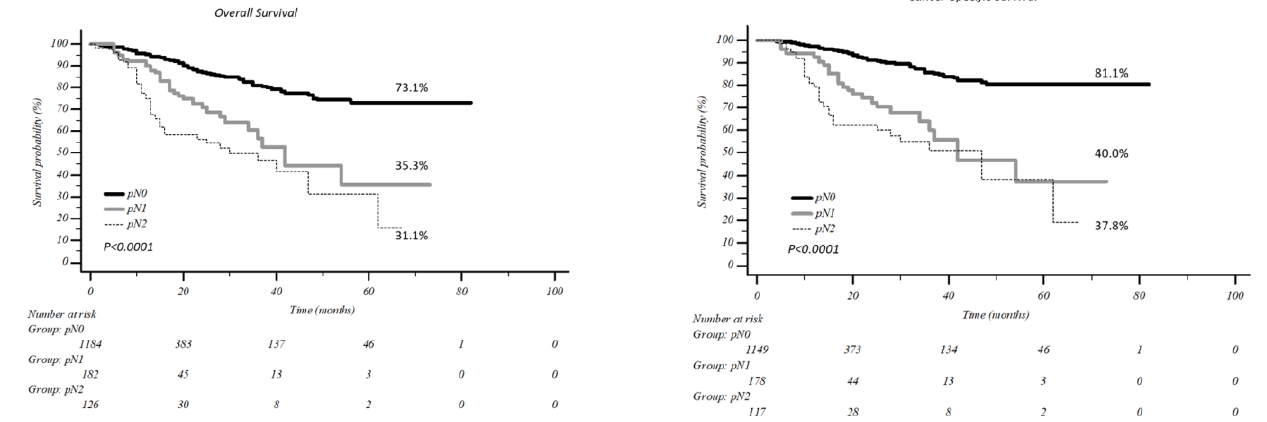
Figure 2. Overall and cancer specific survival according to nodal